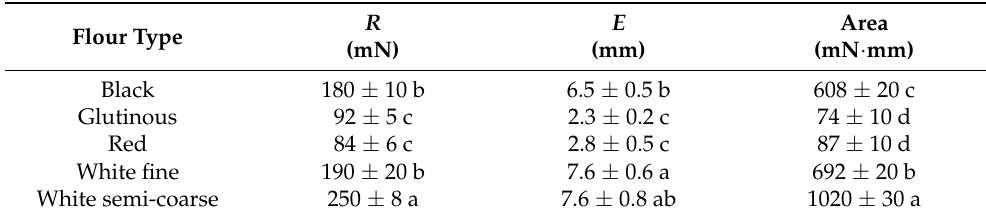
Table 2. Behavior of doughs during the uniaxial elongation test (dough resistance to extension R , dough extensibility E , and area under curve Area) 2 .